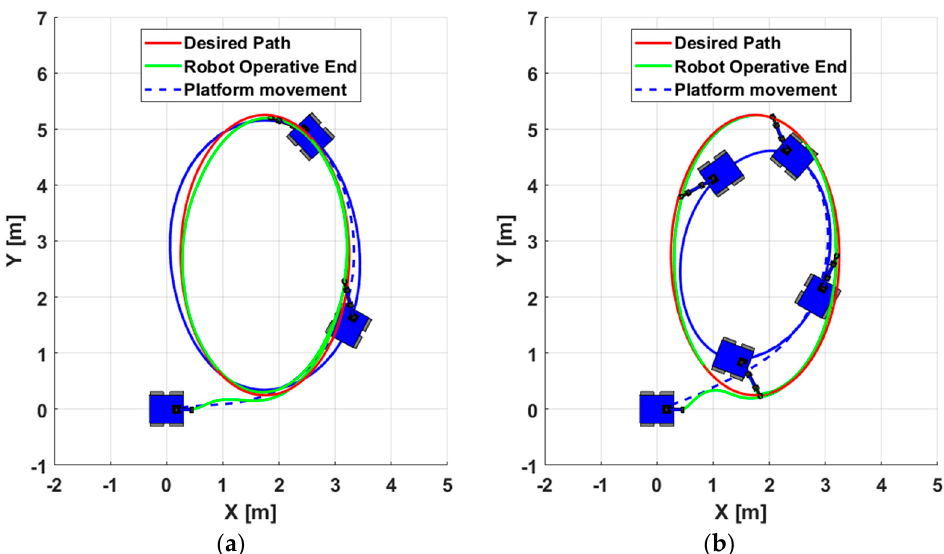
Figure 12. Upper view of the strobe movement of the path following ( a ) without consideration of curvature radius analysis and ( b ) with consideration of curvature radius analysis.